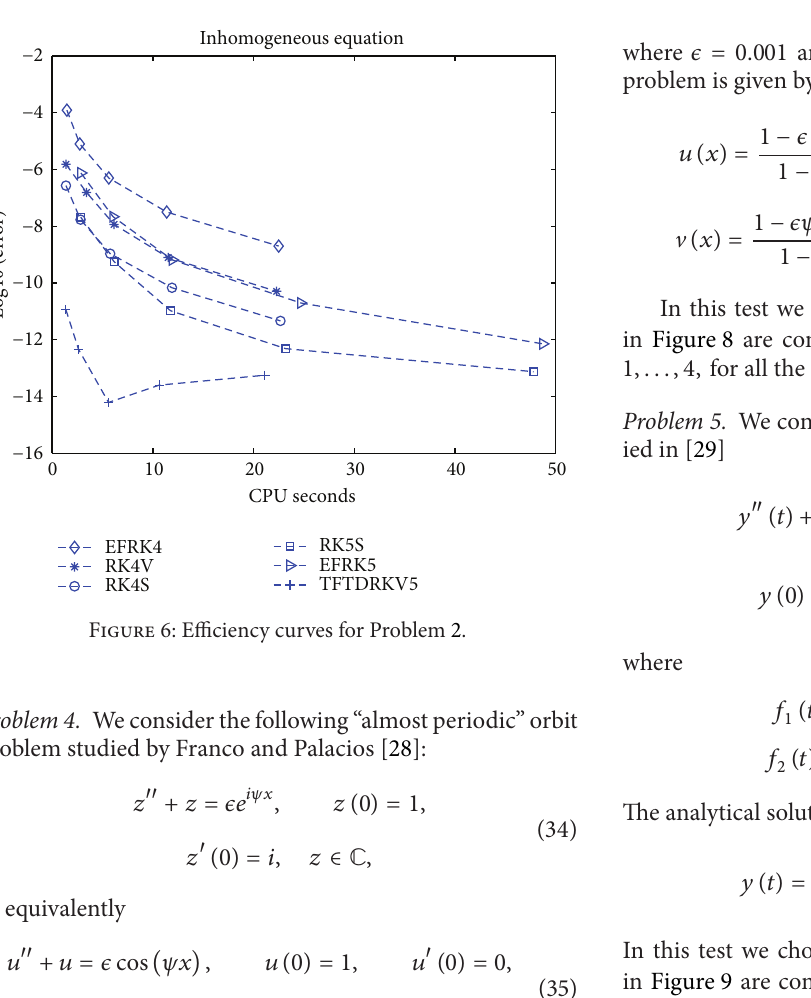
Figure 5: Efficiency curves for Problem 1: 𝐸 = 989.701916 .